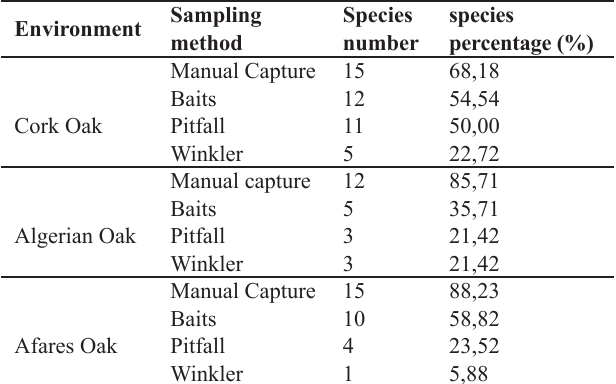
Table 4 . Total number of species and species percentage according